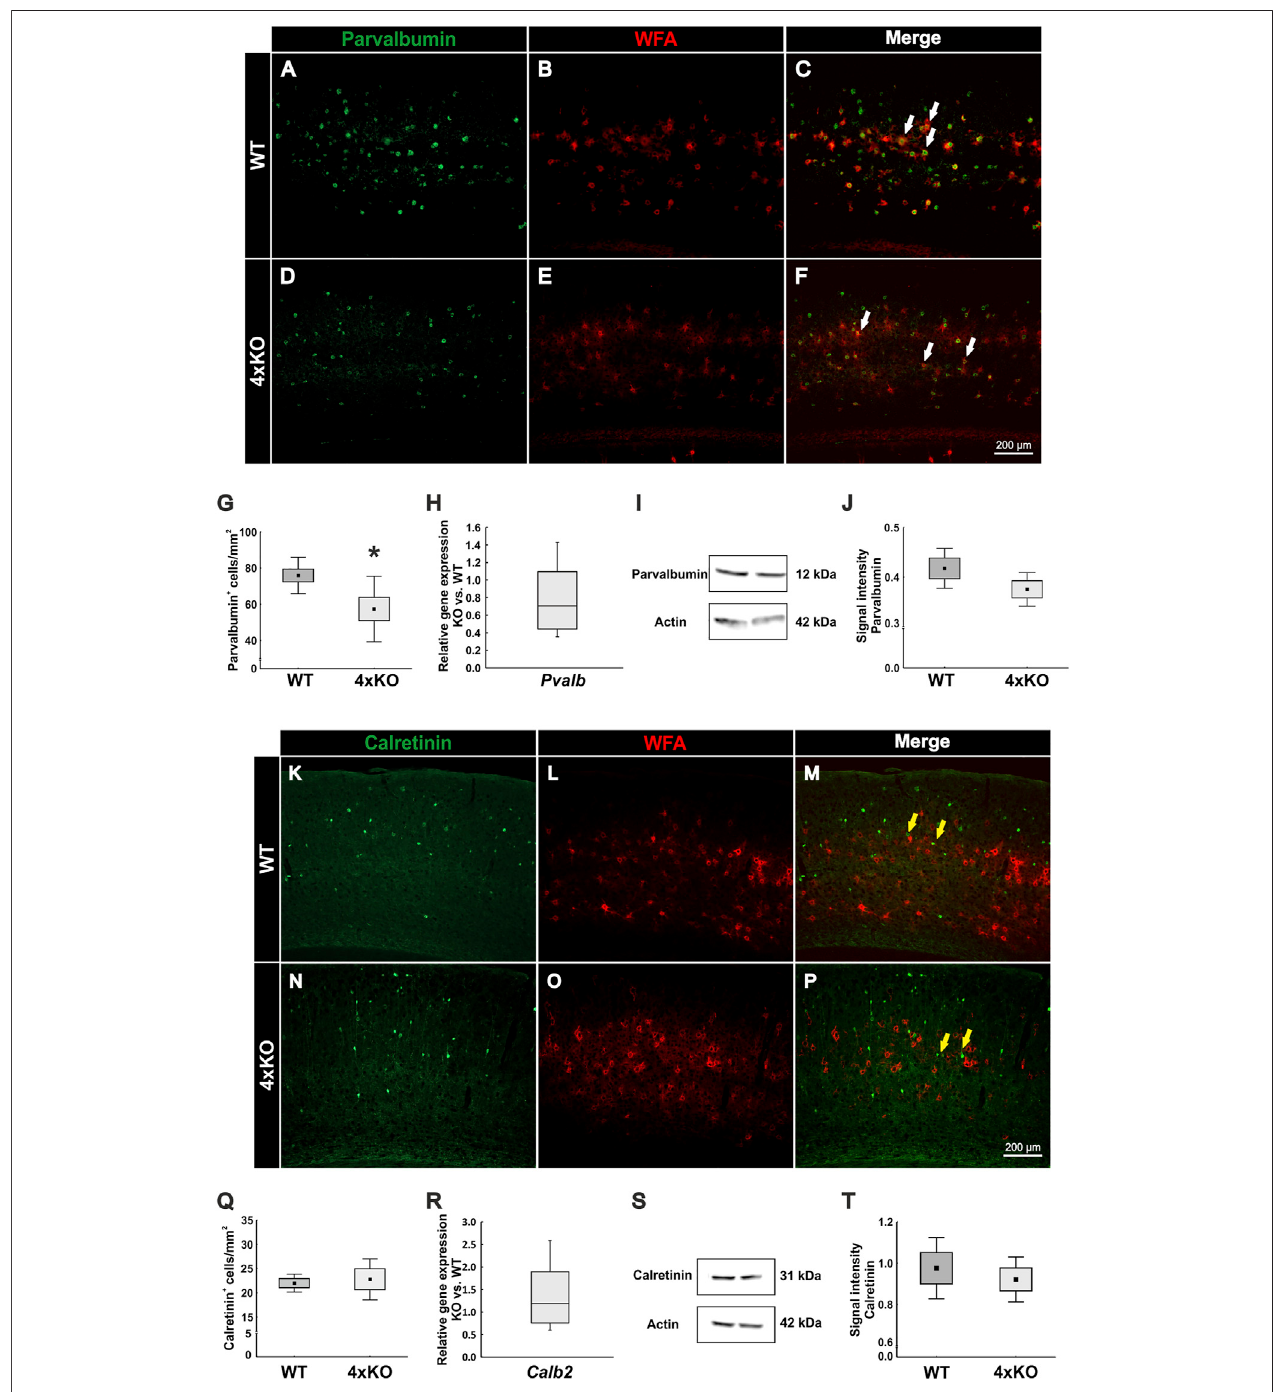
FIGURE 5 | Analyses of parvalbumin-positive and calretinin-positive interneuron populations in the V1 of wildtype and quadruple knockout V1. (A – F) Representative coronal V1 brain sections of wildtype and quadruple KO double-labeled using a speci fi c antibody against parvalbumin and WFA in the V1. Parvalbumin- positive fast-spiking interneurons were mainly PNN-enveloped (white arrows). (G) The number of parvalbumin-positive cells was signi fi cantly reduced in the quadruple knockout ( p < 0.05, N = 8). (H) RT-qPCR analyses revealed a comparable Pvalb mRNA expression in the visual cortex of wildtype and quadruple knockout mice ( p = 0.09, N = 6). (I) Western blot analyses of parvalbumin in the visual cortex of wildtype and quadruple knockout. A prominent band was detected at 12 kDa. (J) Statistical analyses revealed comparable parvalbumin protein levels between wildtype and quadrupleknockout ( p = 0.14, N = 7). (K – P) Representative coronal V1brain sections of wildtype and quadruple knockout mice double-labeled with a speci fi c antibody against calretinin and WFA. In contrast to parvalbumin-positive interneurons, calretinin-positive fast-spiking interneurons were not enveloped by PNNs (yellow arrows). (Q) Statistical analyses showed a comparable number of calretinin-positive